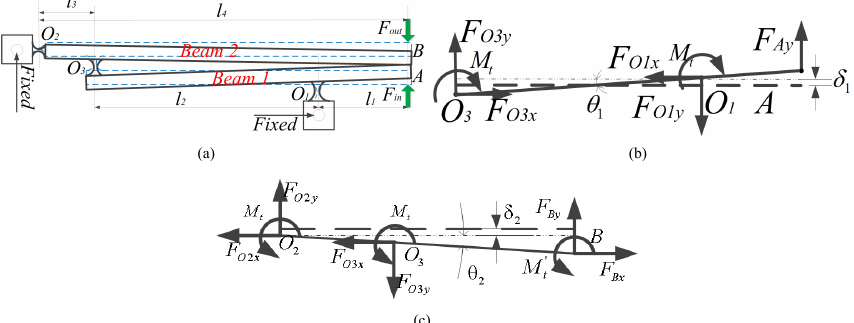
Figure 7. Force diagram: (a) the deformation of the half of the amplifier; (b) forced diagram of beam 1; (c) Forced diagram of beam 2. 2 + k + k + k ( k O O 1 t ) O 1 l k 2 l 2 )( k O 3 t 1 l k in1 =